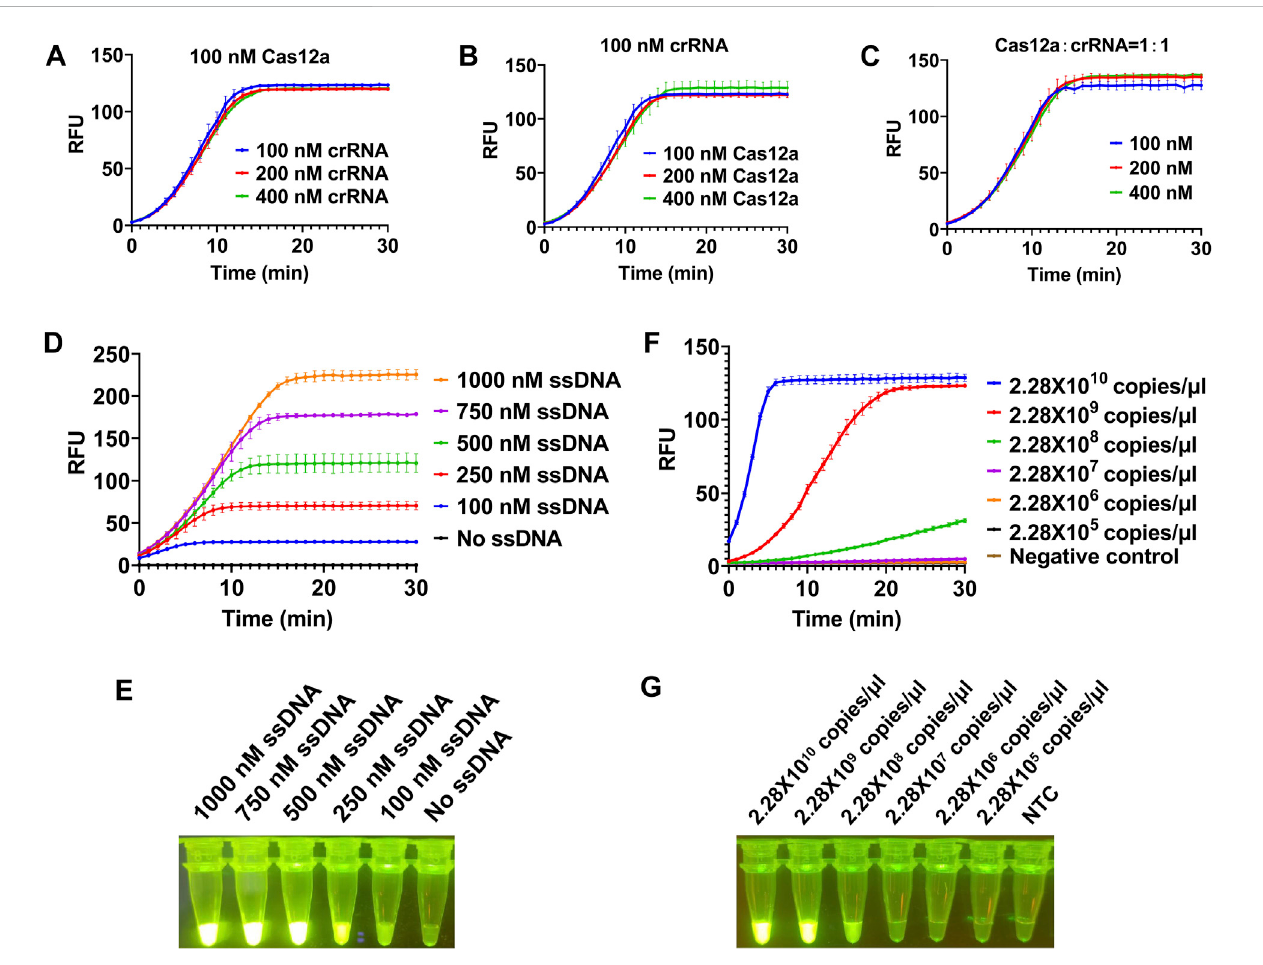
Optimization of reaction conditions for CRISPR/Cas12a-based visual detection. The SrMV RT-RAA product was cloned into vector and the plasmid was used for theoptimization ofthe CRISPR/Cas12asystem. (A) The concentration ofCas12a proteinwas constant, and theconcentration of crRNA inthesystem was optimized. (B) The concentration of crRNA was constant, and the concentration of Cas12a protein in the system is optimized. (C) The concentration of Cas12aproteinandcrRNAwasoptimizedinequal proportion. (D) Real-time fl uorescencesignal analysis ofssDNAprobesatdifferentconcentrations. (E) Determination of optimal ssDNA concentration by visual observation. (F) Real-time fl uorescence signal analysis of plasmid templates at different concentrations. (G) Determinationofoptimalplasmidtemplatesconcentrations byvisualobservation.n=3technicalreplicates,anddatapointsareshownas mean ±